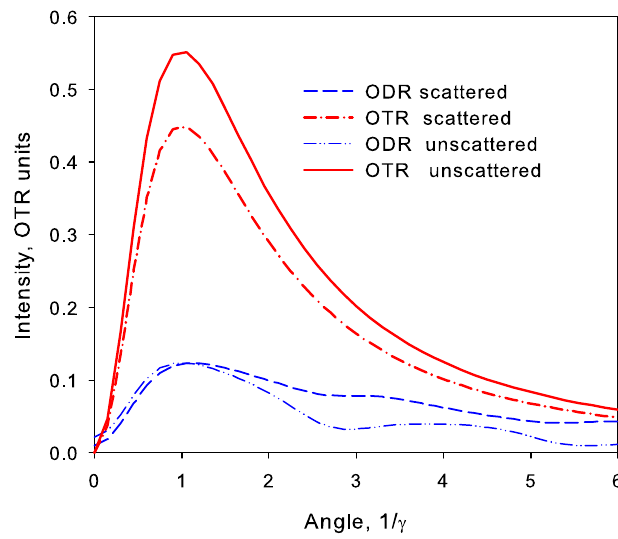
FIG. 5. (Color) Computer simulation of the parallel components of intensities of the ODR and OTR from the scattered and unscattered components of the copper micromesh; tilt angle of the plane of observation ’ (cid:2) 0 ; particle trajectory is parallel to the z